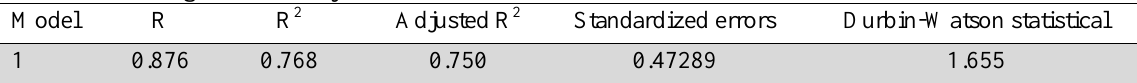
The results of regression analysis